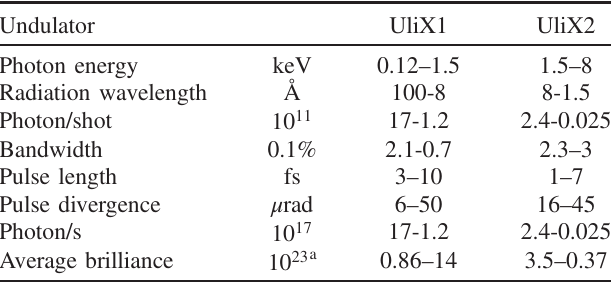
TABLE VIII. MariX FEL characteristics.